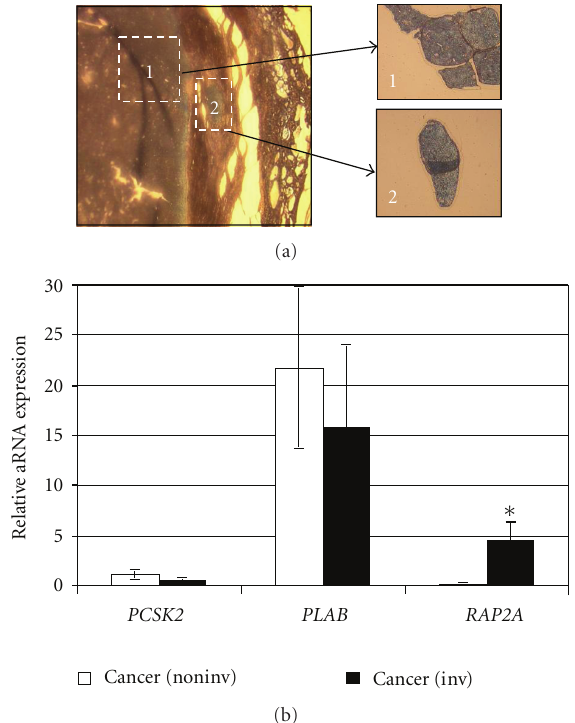
Figure 2: An example of laser-capture micro-dissection in follicular thyroid carcinoma. (a) FTC tissue before (left) and after collecting the groups of cells from the main tumor mass (inset 1) and angioin- vasive area (inset 2). Original magnification, 200x. (b) Histogram, relative expression of PCSK2, PLAB, RAP2A in the cells collected from matched noninvasive and invasive areas of the same specimens ( n = 4). Mean of normalized expression levels of aRNA in each group is shown. Bar, SEM. ∗ P = 0 .